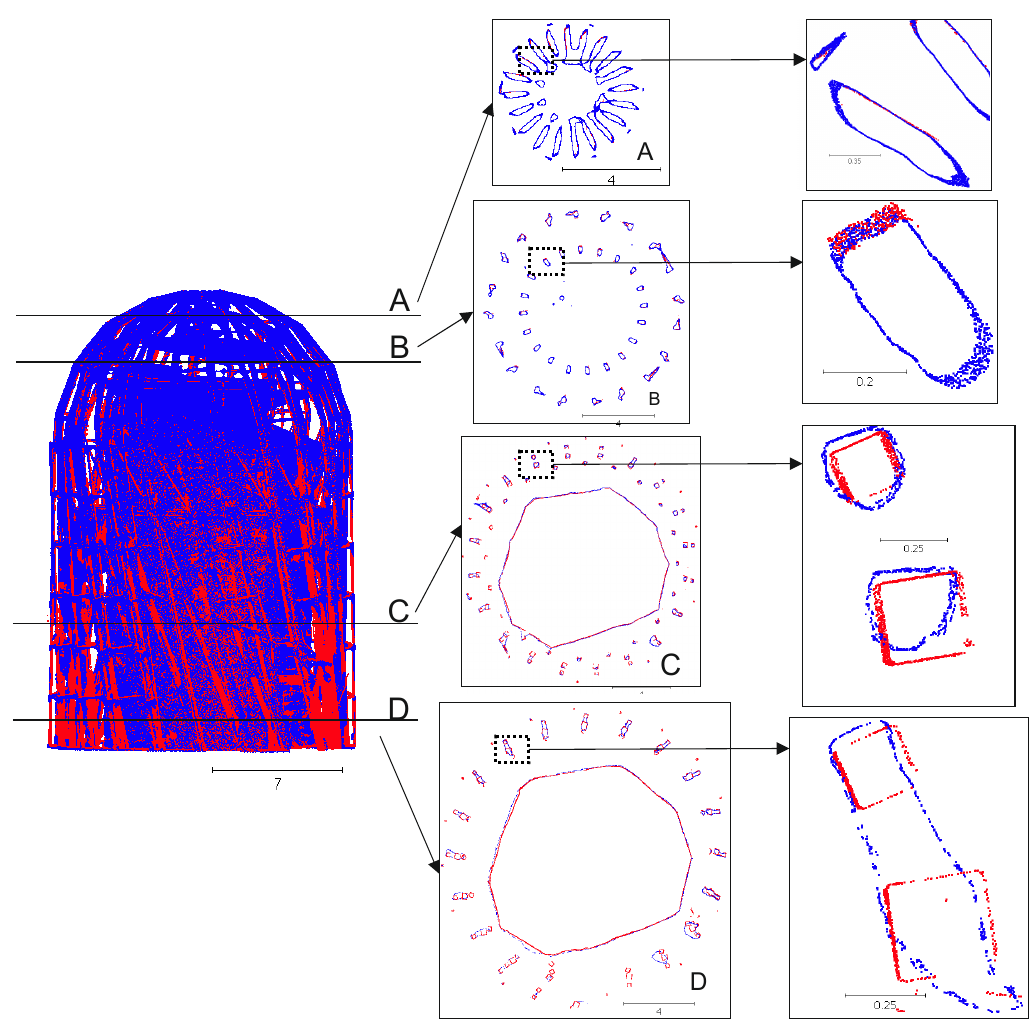
Figure 11. Cross-sections of the integrated point clouds: blue, the UAV cloud; red, the TLS point cloud (values in meters).